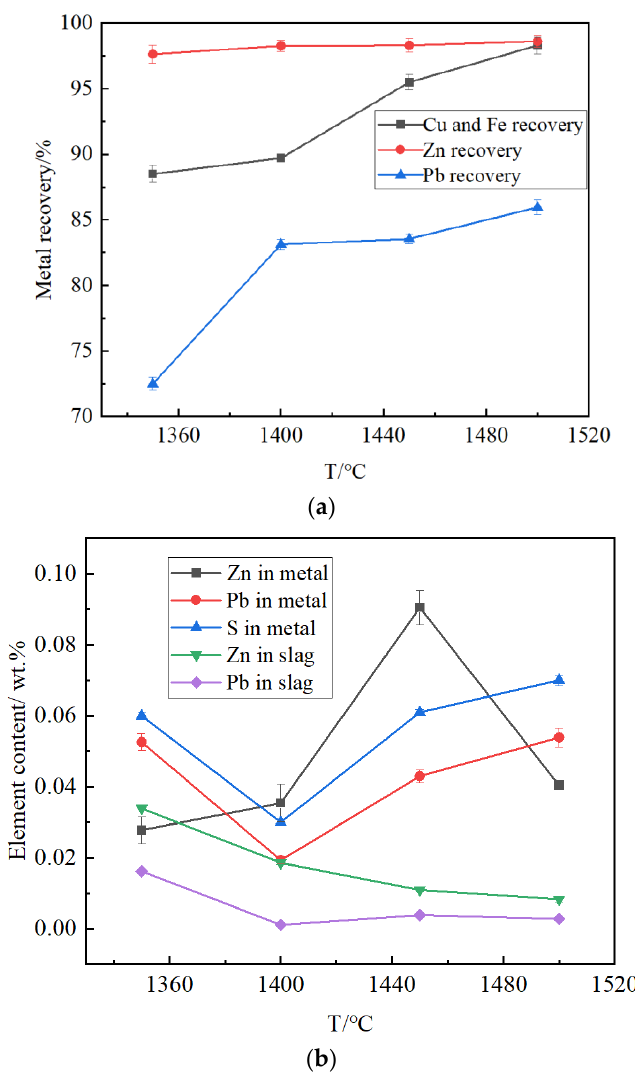
Figure 8. The effect of temperature on the reduction of slag ( a ): metal recovery, ( b ): element content in metal and slag.